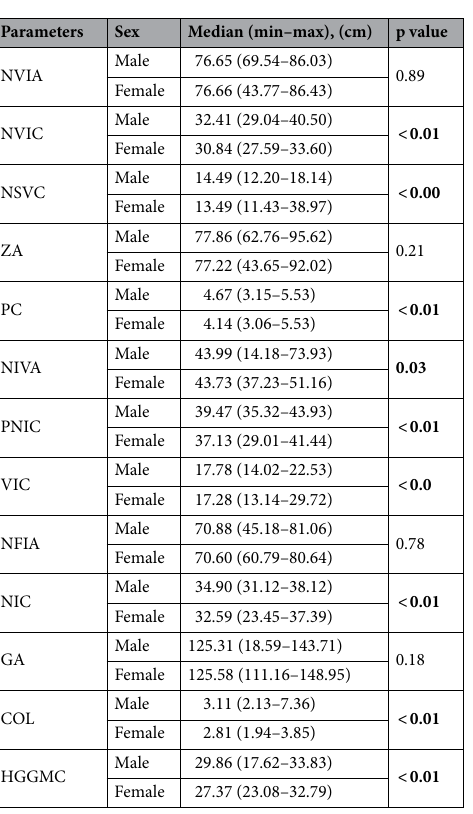
Table 2. Comparison of non-parametric data of males and females. NVIA: Nasion–vertex–inion angle, NVIC: Nasion–vertex–inion curvature length, NSVC: Nasion–superciliary arch–vertex curvature length, ZA: Zygomatic angle, PC: Piriform aperture curvature length, NIVA: Nasion–inion–vertex angle, PNIC: Piriform aperture–Nasal end point–inion curvature length, VIC: Vertex–inion curvature length, NFIA: Nasion–frontal tuber–inion angle, NIC: Nasal end point–inion curvature length, GA: Gonial angle, COL: Coronoid process– obliqua line length, HGGMC: Head of mandible–gonion–gnathion–mandibular notch curvature length. Significant values are in